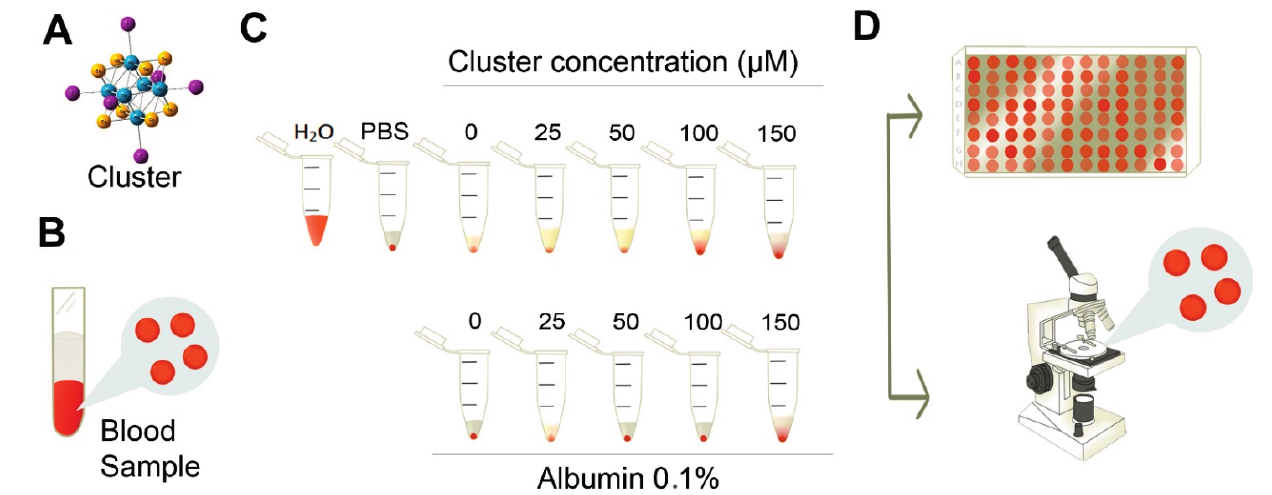
Figure 5. Scheme of experimental procedure. ( A ) Hexanuclear rhenium [Re 6 Se 8 I 6 ] 3 − cluster complex; ( B ) to test the hemolysis effects of the cluster on erythrocytes in vitro , blood samples from human donors were obtained, and erythrocytes were isolated; ( C ) erythrocytes (1%) were exposed to different concentrations of the cluster. Suspension in distilled water was considered the control of 100% hemolysis; ( D ) Absorbance of free hemoglobin was measured in an ELISA plate, to estimate % of hemolysis. The morphology of erythrocytes was analyzed under an inverted